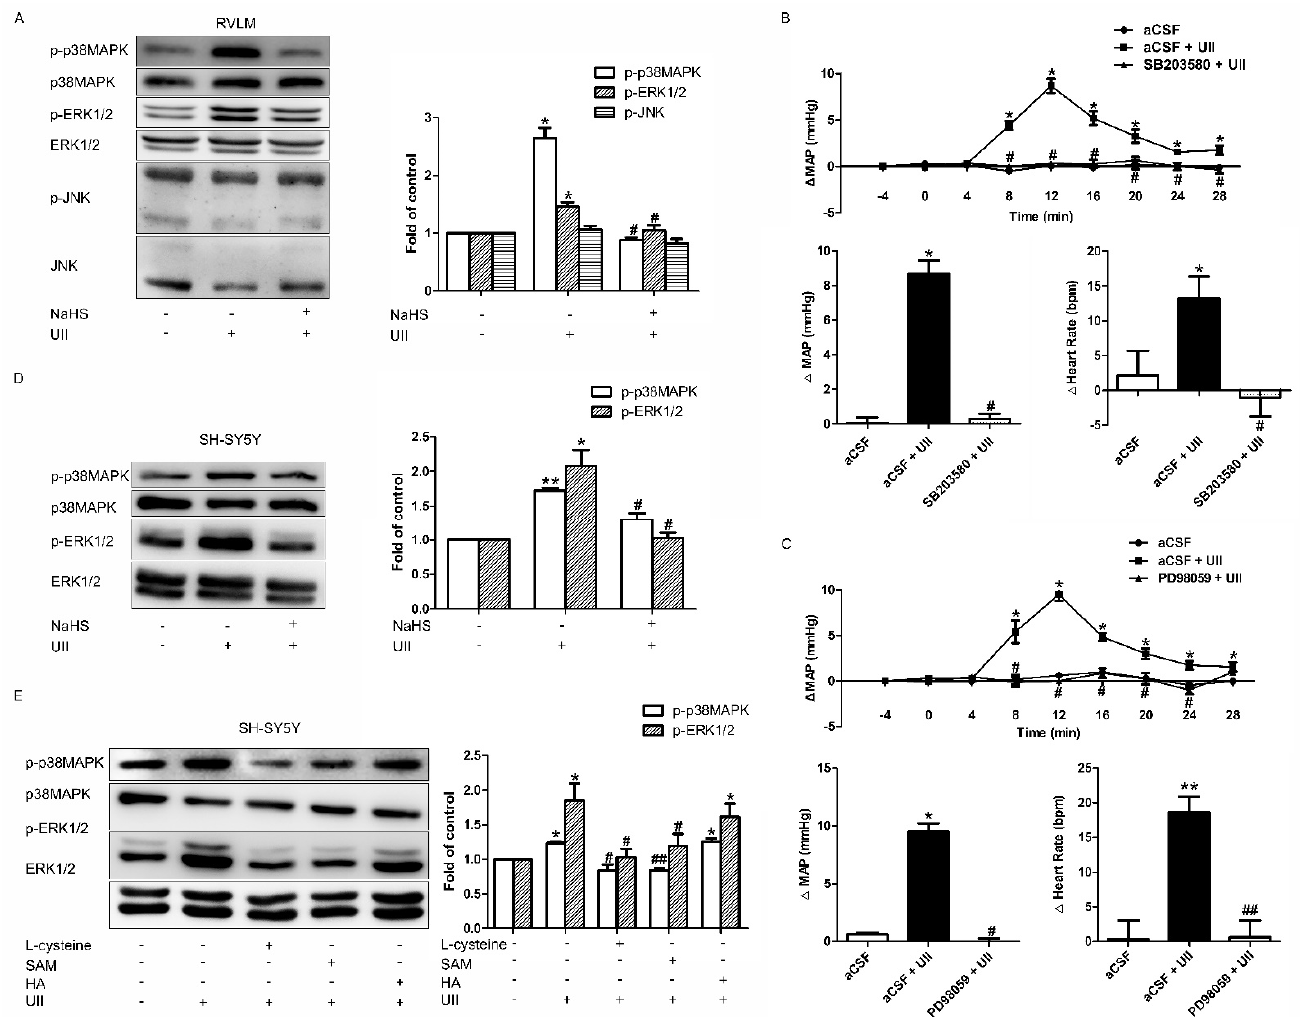
Figure 8. Inhibitory role of H 2 S on UII-induced p38MAPK and ERK1/2 activation. Representative Western blots analysis showing the change in p − ERK1/2, p-p38MAPK, and p − JNK after microinjection of aCSF ( n = 6), aCSF + UII ( n = 6), or NaHS + UII ( n = 6) into the RVLM of SD rats ( A ). Microinjection of PD98059 and SB203580 into the RVLM decreased UII − induced MAP and HR rise in SD rats. Time course of MAP in response to microinjection of aCSF, aCSF + UII, or